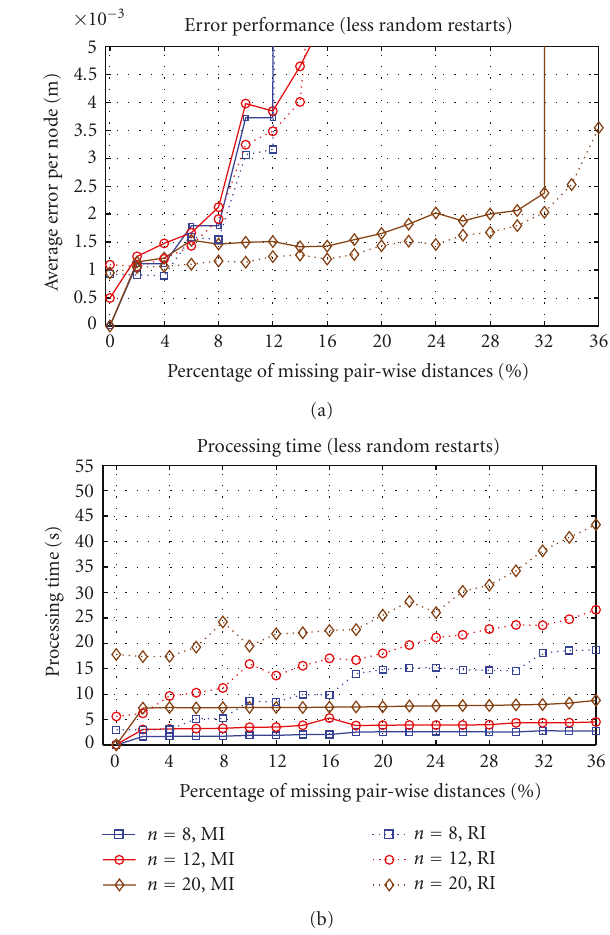
Figure 6: (a) Error performance; (b) processing time with the number of multiple restart is constrained to 15, an empirical level at which both the error and missing distance tolerance performances are comparable for both